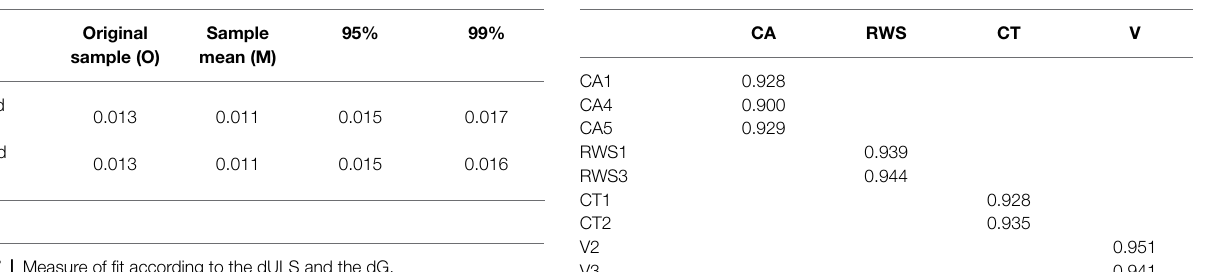
TABLE 8 | Outer model loadings. TABLE 6 | Measure of fit according to the SRMR.